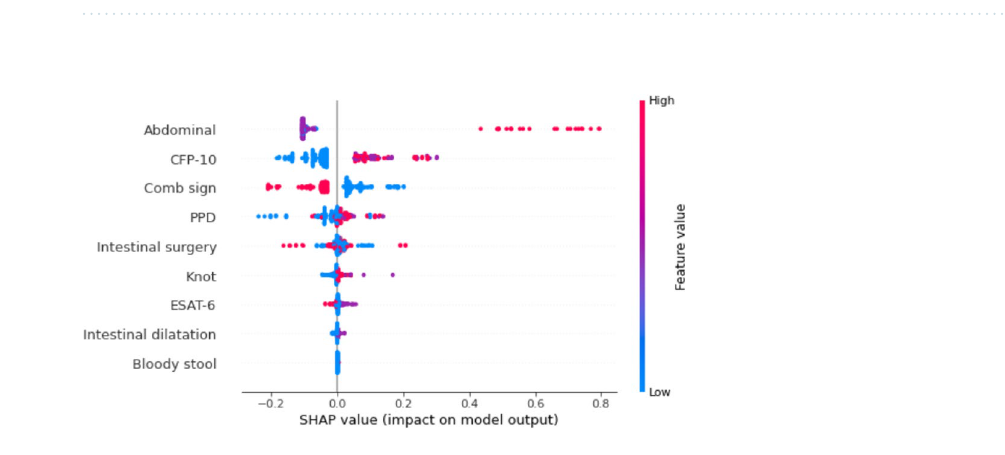
Table 2. Performance of different methods for distinguishing CD from ITB.